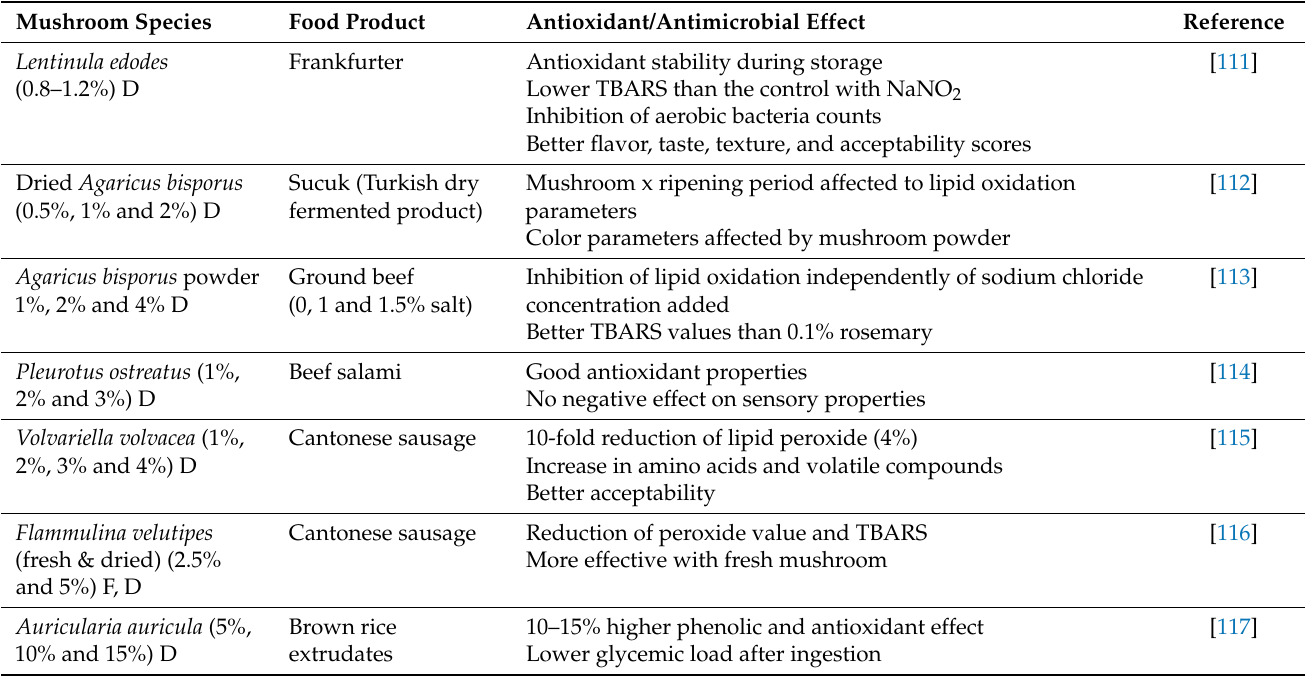
Table 2. Antioxidant, antimicrobial and sensorial effects of the incorporation of edible mushrooms in food products. Mushroom Species Food Product Antioxidant/Antimicrobial Effect